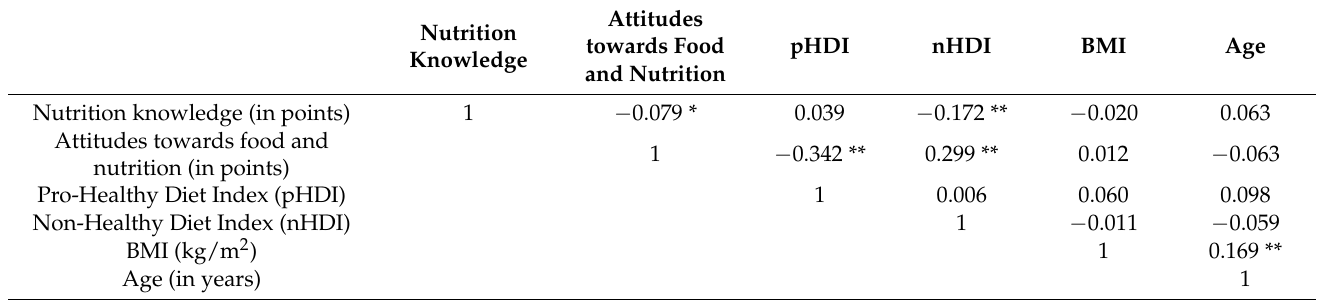
Table 4. Correlations between nutrition knowledge, diet indices, BMI, and participants’